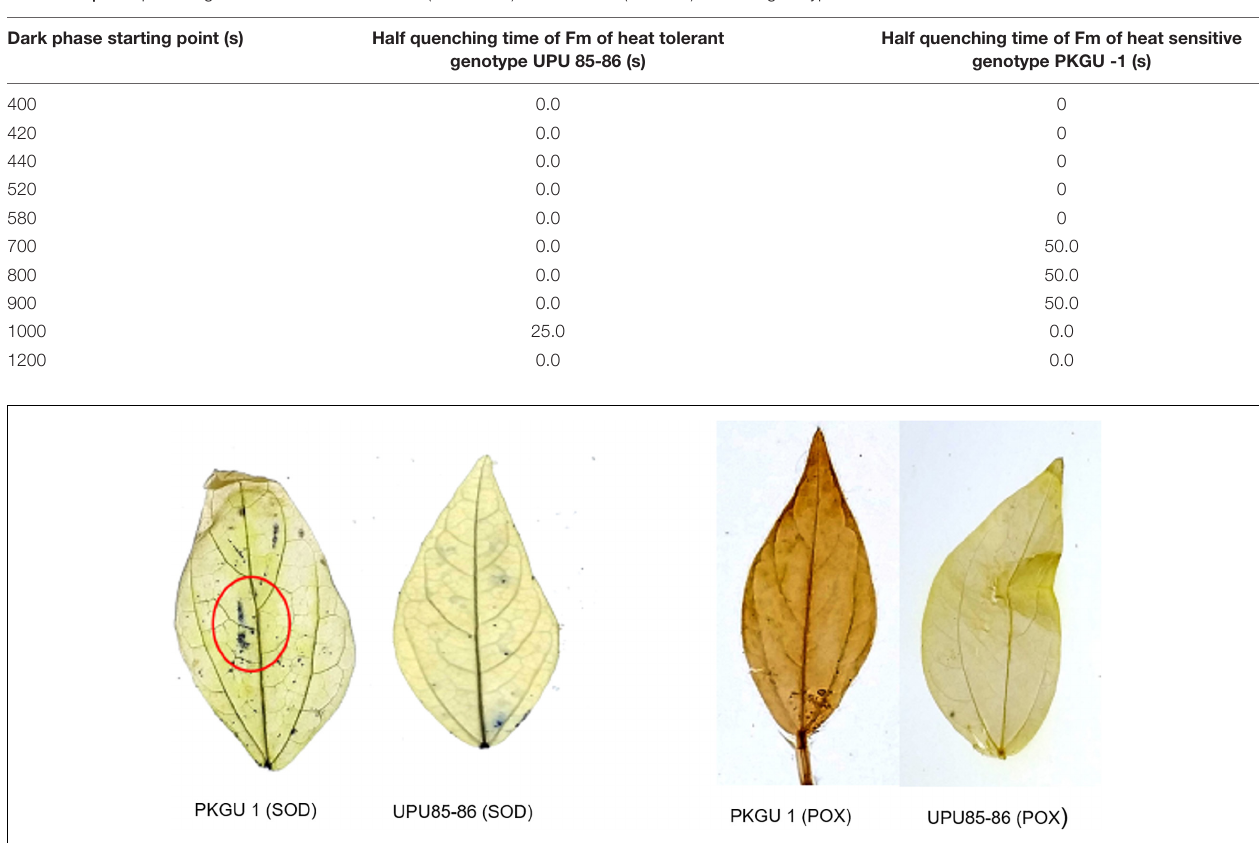
FIGURE 7 | In vivo visualization of antioxidant activity for superoxide radicals and hydrogen peroxides in heat sensitive and tolerant genotypes.